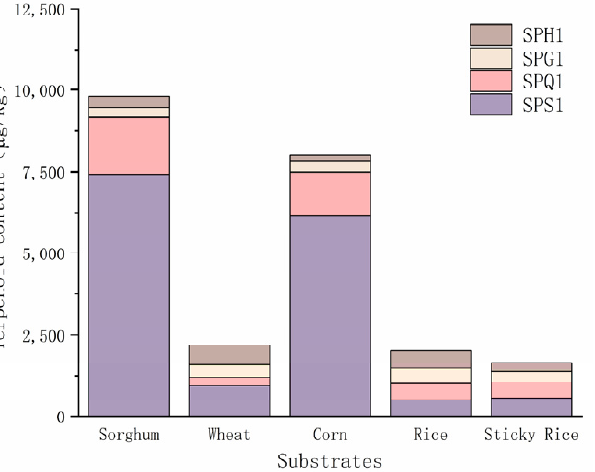
Figure 4. Content of terpenoid products from solid-state fermentation of different types of substrates at 28 days.